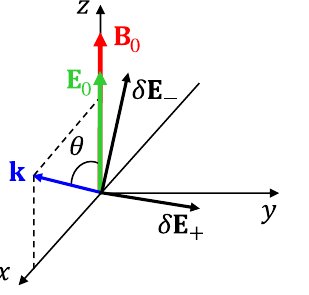
Fig. 6 Configuration of the background fields ( E 0 , B 0 ) and the probe field. The probe field has its propagation vector k on the xz -plane and its two polarization vectors δ E ± associated with the refractive indices n ± . Unless E 0 = 0 (thus (cid:15) 2 = 0), δ E + is not along the y -axis, and δ E − is not on the xz